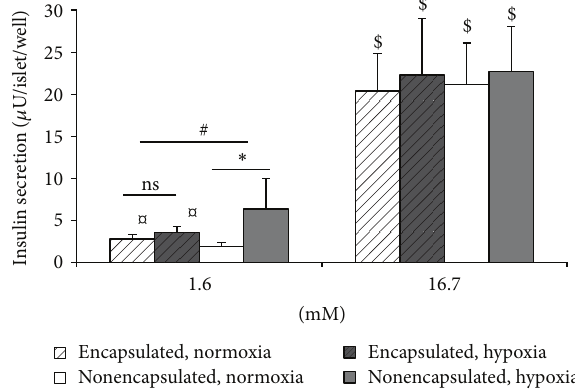
Figure 1: Effect of hypoxia and encapsulation on insulin secretion at 1.6 and 16.7 mM glucose. $ 𝑃 < 0.02 for the stimulatory effect of 16.7 mM glucose, ∗ 𝑃 < 0.02 for the effect of hypoxia, ¤ 𝑃 < 0.04 for the effect of encapsulation, and # 𝑃 < 0.02 for the effect of hypoxia on encapsulated versus nonencapsulated islets at basal secretion. Data are mean ± SEM of eight separate experiments (five-six parallels perexperimentalcondition),one-threeexperimentsperdonor(four